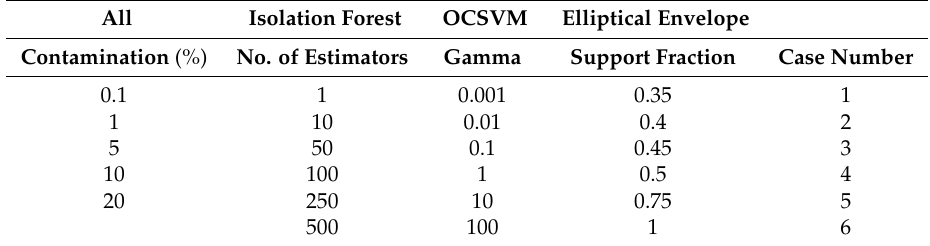
Table 3. Table of hyperparameters considered in this